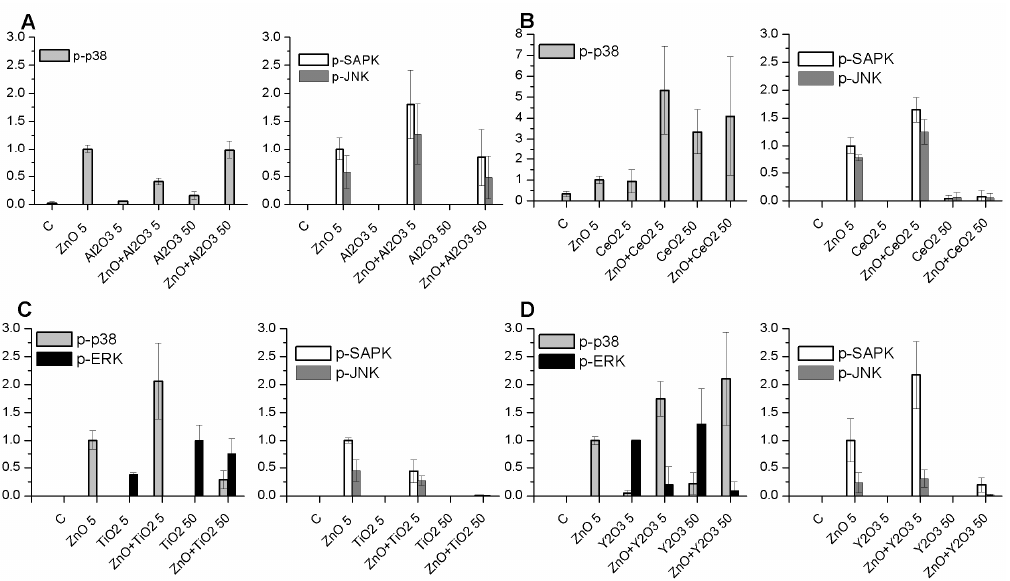
Figure 3. Expression of p-p38, p-ERK and p-SAPK/JNK in Jurkat cells. The graphs show the expression of p-p38, p-ERK and p-SAPK/JNK in cells treated with Al 2 O 3 , CeO 2 , TiO 2 and Y 2 O 3 ( A – D ) at different concentrations (5 and 50 µg/mL) and combined with 5 µg/mL ZnO.